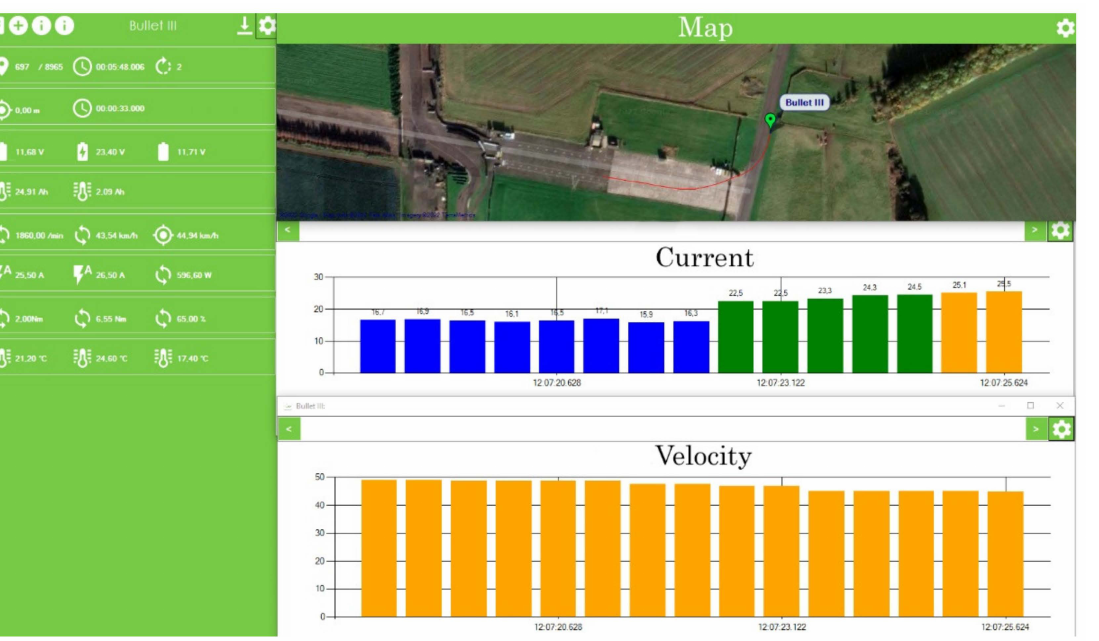
Figure 4. View of the parameters of the actual car run presented in the Silesian Greenpower telemetry system